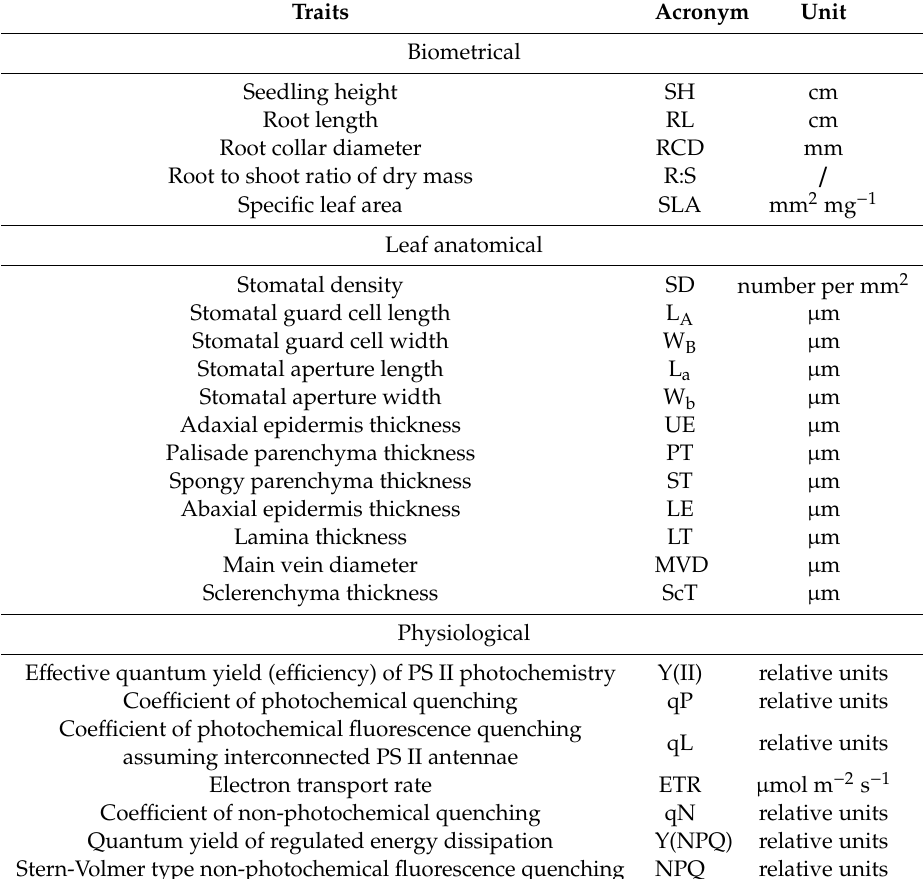
Table 1. List of the studied parameters.